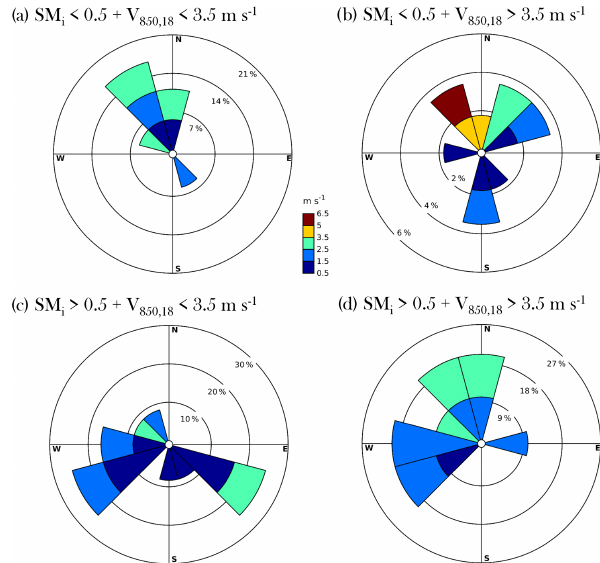
Figure 5. Wind roses representing the maximum downslope wind speed at 6m in colours, for different directions from the National Centers for Environmental Prediction (NCEP) reanalysis wind at 850hPa, at the closest grid point from La Herrería (40.5 ◦ N, 4 ◦ W) at 18:00UTC. Wind roses are shown for different values of the soil- moisture index (SM i ) and the reanalysis wind speed ( V 850 , 18 ) (a– d) . Note that the frequency scale of the wind roses is